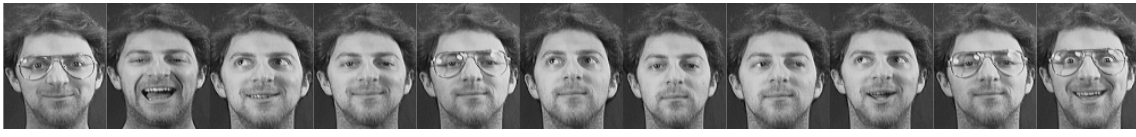
Fig. 4 Training and Testing Images taken from The ORL Database